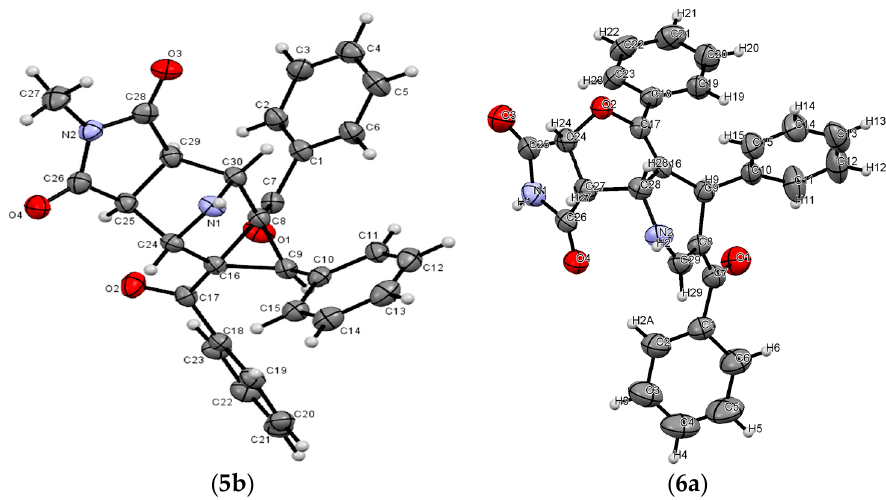
Figure 1. X-ray crystal structures of ( 4d ), ( 5a ) , ( 5b ) and ( 6a ).